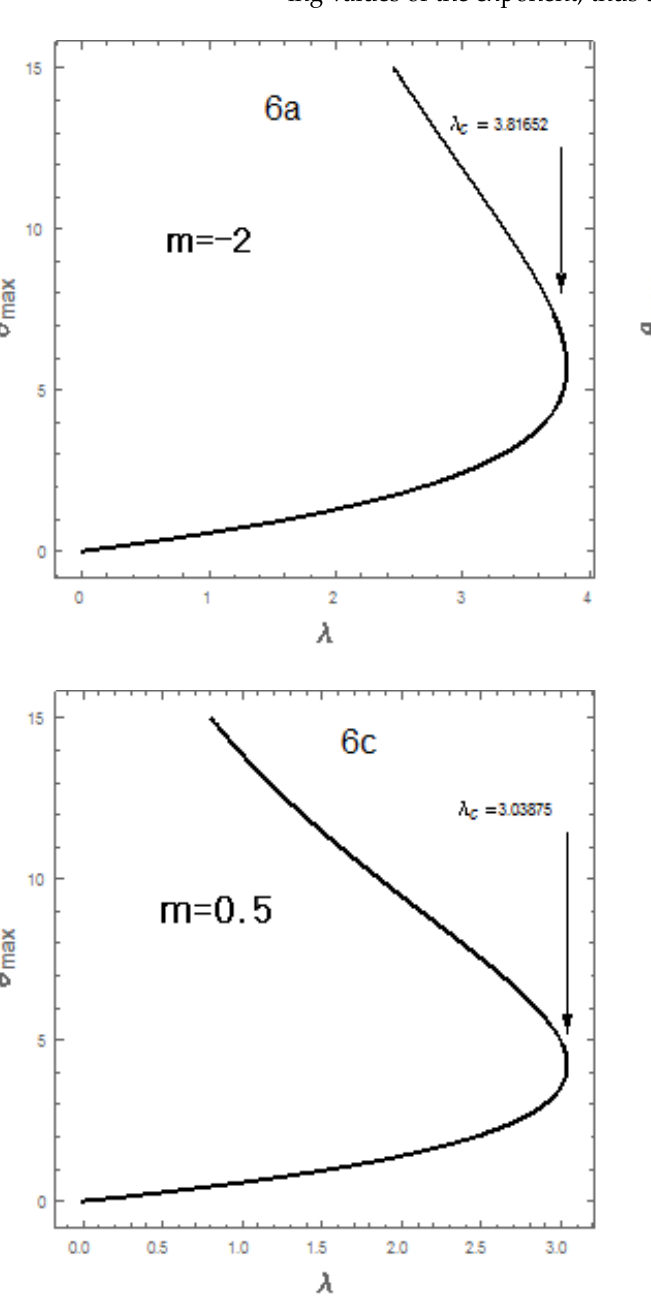
Figure 6. Bifurcation plots when Gr = 7, σ = 0.1 = ε = η = α , δ = 0.2, γ = 0.3, Bi 1,2 = 10